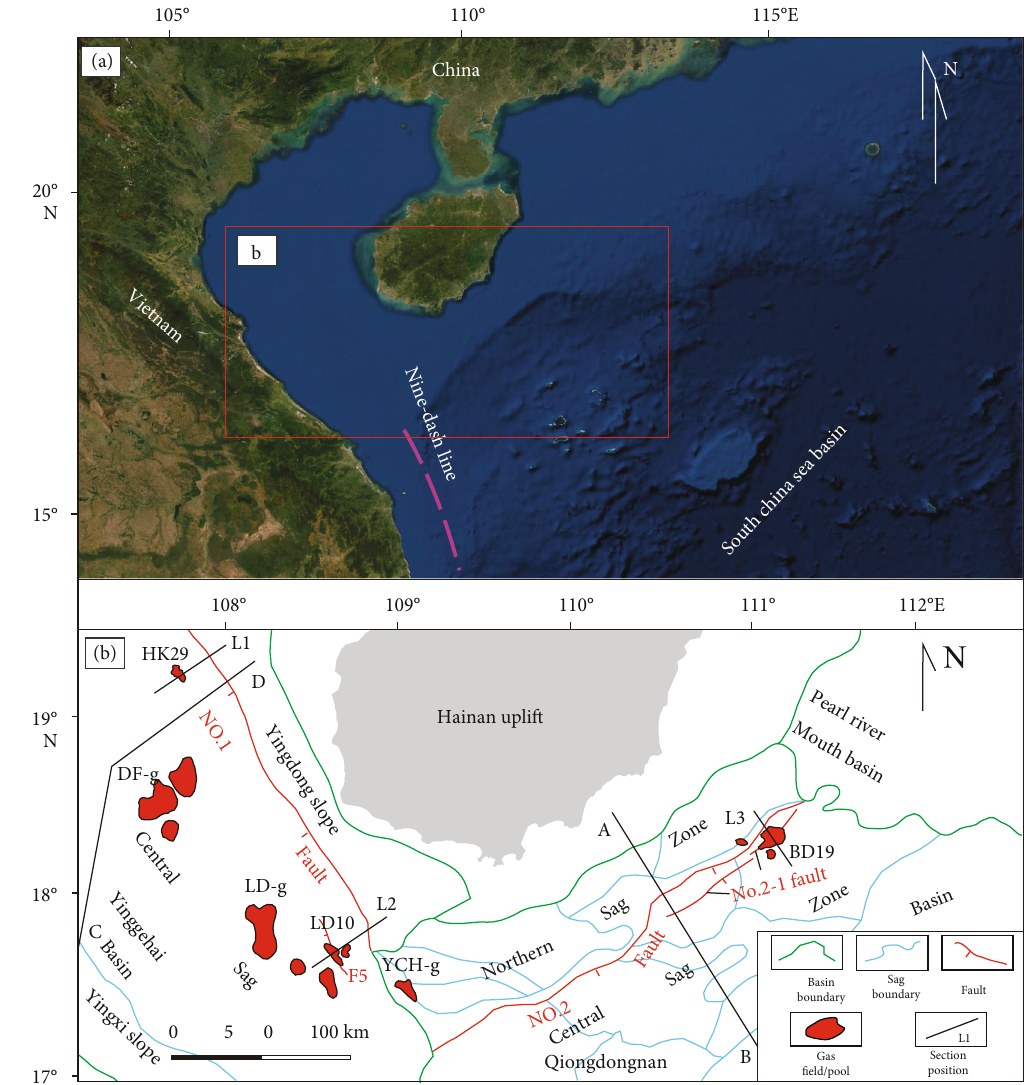
Figure 1: Map of study area. (a) Geographical location of study area. (b) Structural divisions, sections, and gas fi elds/pools of the Yinggehai and Qiondongnan Basins. DF-g: Dongfang gas reservoir, LD-g: Ledong gas reservoir, YCH-g: Yacheng gas